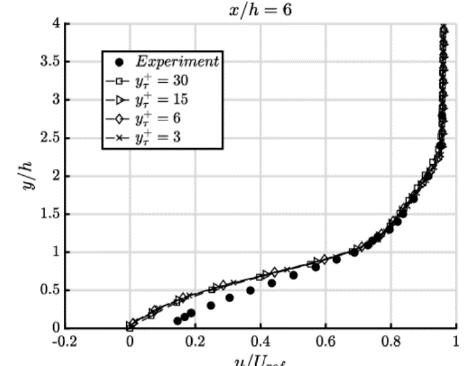
Figure 7. Streamwise velocity distributions at the location x/h = 6 as the function of normalized wall distance, y ,. The velocity was normalized by the reference velocity, U ref , defined in Reference [50] for each